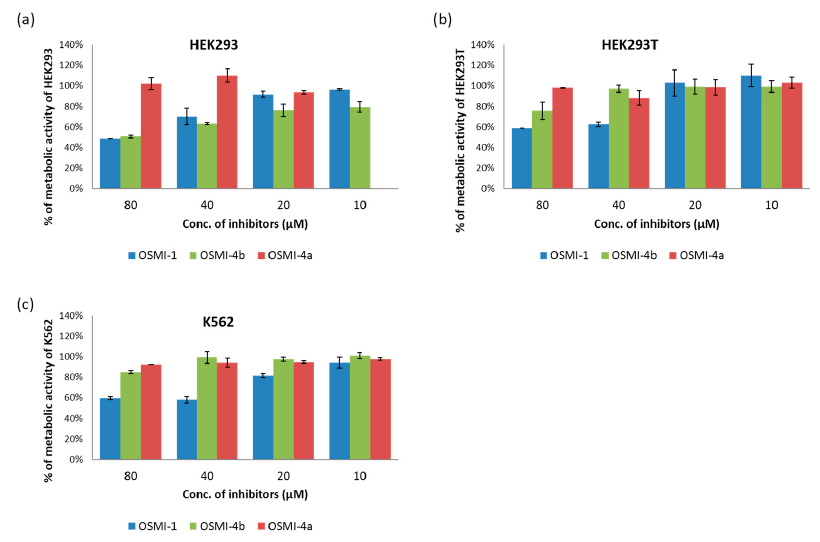
Figure 3. E ff ects of metabolic activity after 96 h treating HEK293 ( a ), HEK293T ( b ), and K562 ( c ) cells with OSMI-1, OSMI-4a, and OSMI-4b. The results are presented as the percentage of metabolic activity of the control cells stimulated with the vehicle (mean + SD) from two to three independent experiments, each performed in